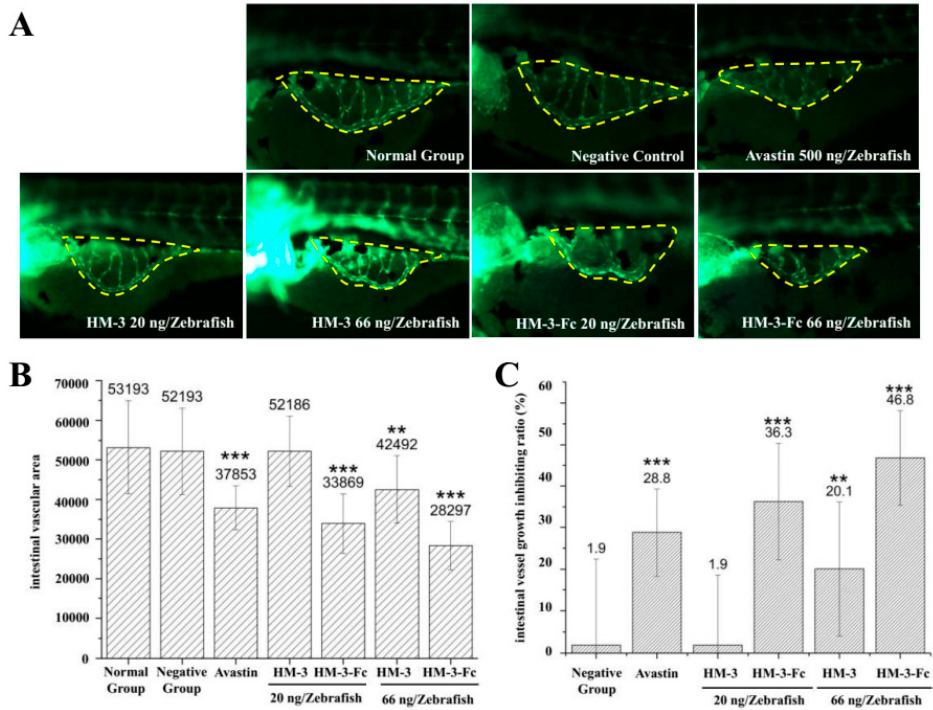
Figure 6. Inhibitory effect of HM-3-Fc on angiogenesis in zebrafish. Zebrafish were subcutaneously injected with HM-3 or HM-3-Fc and also with Avastin as a positive control. After 24 h, intestinal vascular area was visualized and measured and then angiogenesis inhibition rates were calculated based on the vascular area of each group. ( A ) Typical photos of zebrafish intestinal vascular area in different groups (150×). ( B ) The intestinal vascular areas of zebrafish in each group were visualized and measured by Nikon NIS-Elements D 3.10. And the areas of intestinal blood vessels in the experiment were calculated (S). ( C ) Angiogenesis inhibition rate = (1 − S(Normal Group)/S (Experiment Group)) × 100%. Results were presented as mean ± SD ( n = 12). ** p < 0.01, *** p < 0.001.